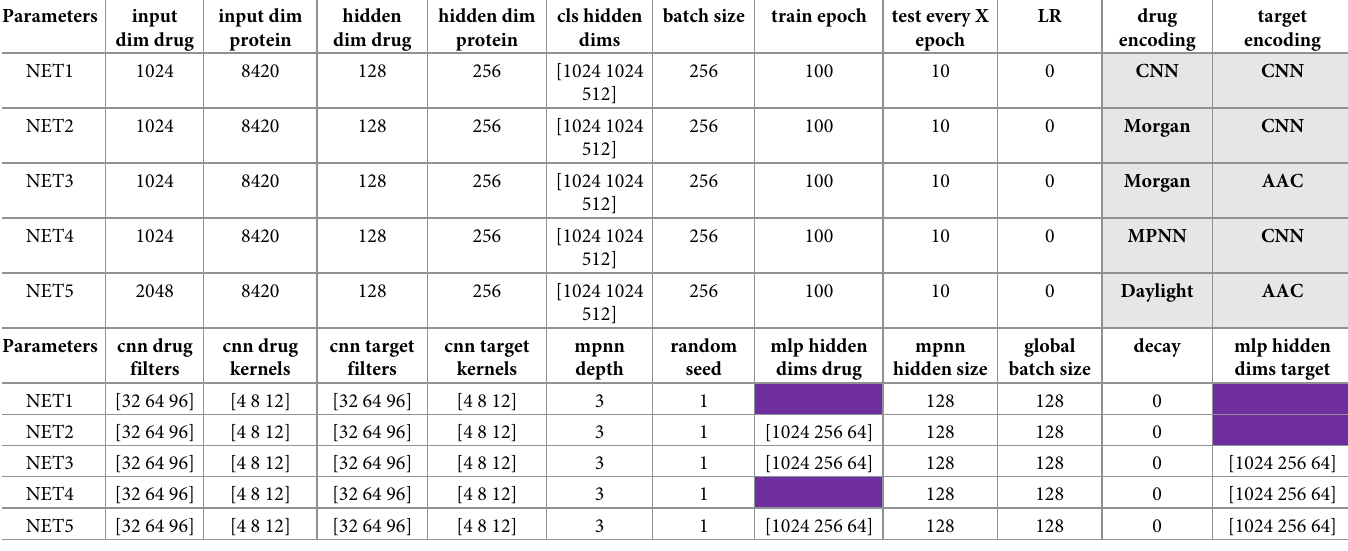
* Violet colours indicate that these parameters are not applicable for those networks.